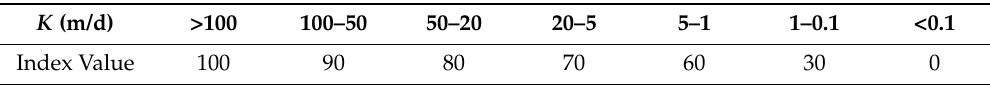
Table 3. Hydraulic conductivity ( K ) scoring criterion.